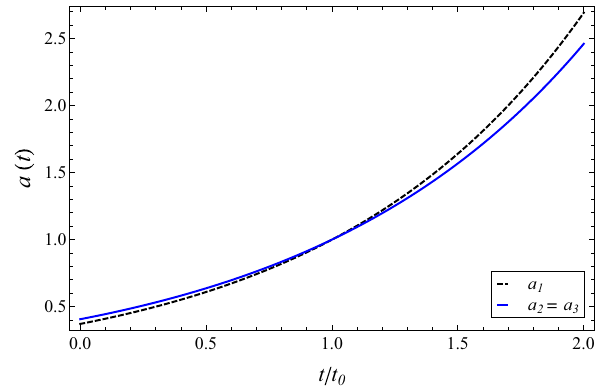
Fig. 1 Scale factors (one for each spatial direction) for a dark energy dominateduniversewhentheKalb–RamondassumesitsVEV,breaking the Lorentz symmetry, in the Bianchi type I geometry. The parameter t 0 = 1 means the present